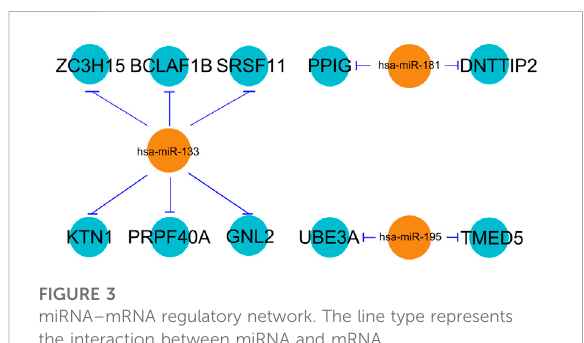
FIGURE 3 miRNA – mRNA regulatory network. The line type represents the interaction between miRNA and